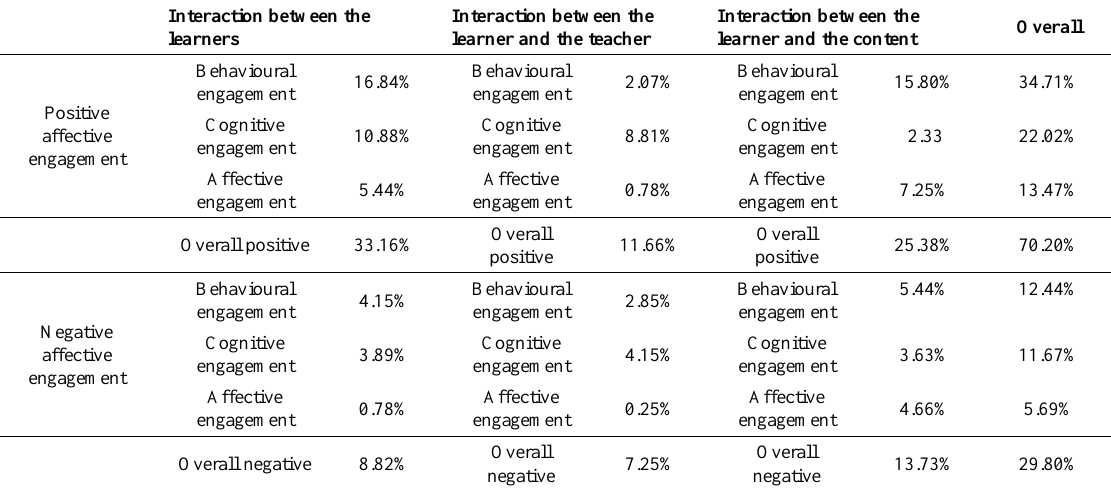
Table 8. Percentages of positive and negative affective engagement in assignment work (N= 386